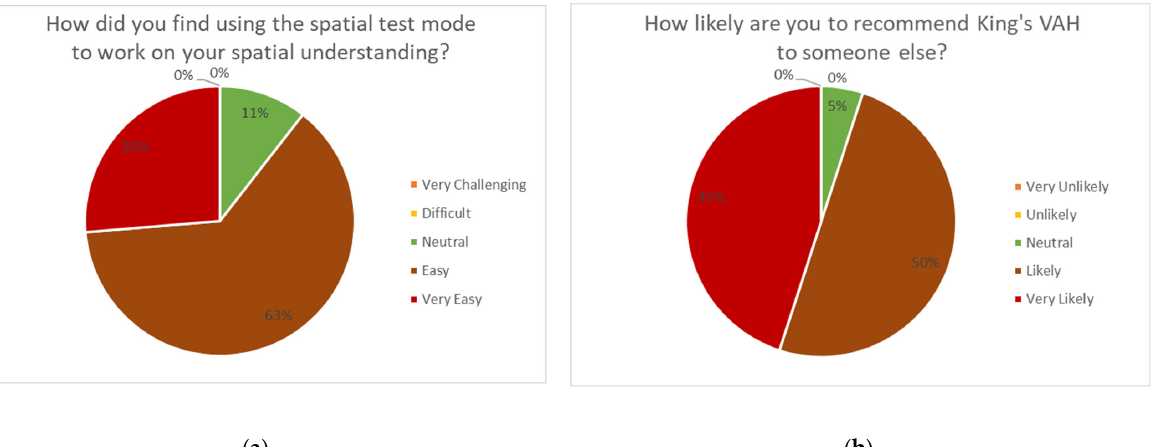
Figure 7. Pie charts of two user experience Likert scale results. ( a ) The figure shows a pie chart of the results to the question “How did you find using the spatial test mode to work on your spatial understanding?”. ( b ) The figure shows a pie chart of the results to the question “How likely are you to recommend King’s VAH to someone else?”.